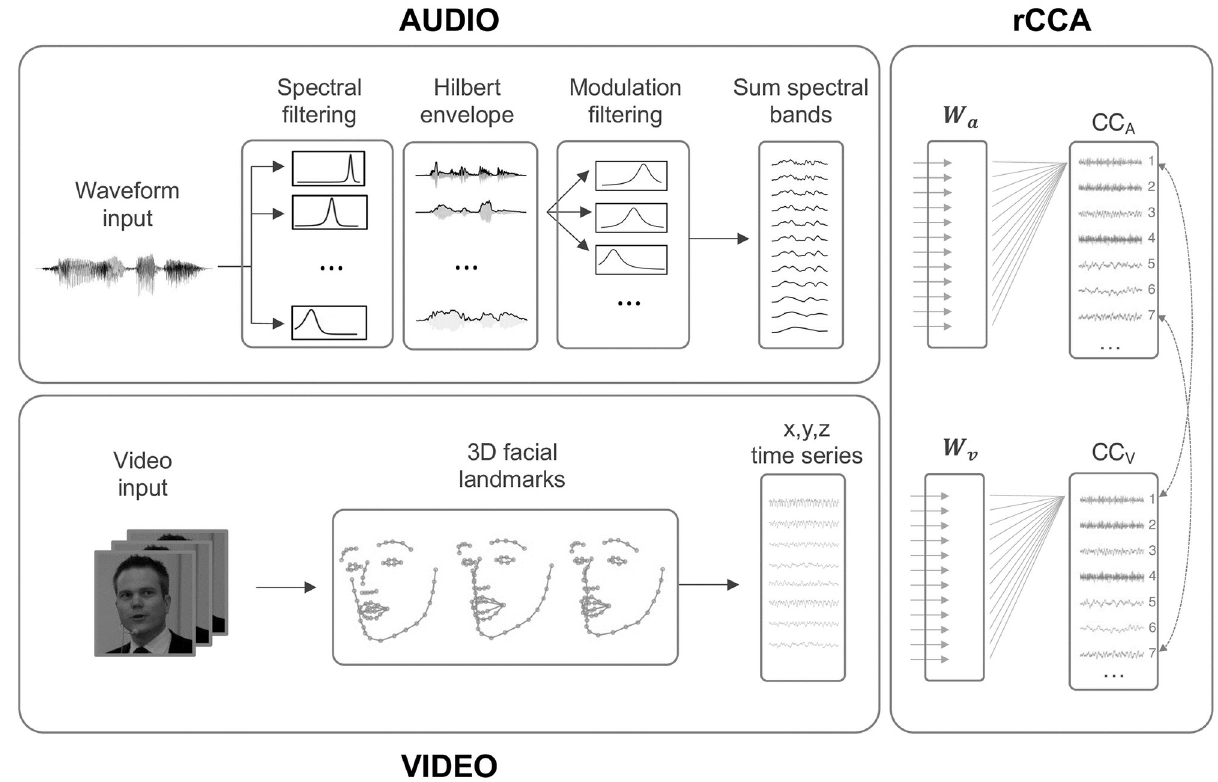
Fig 1. Analysis procedure. Regularized CCA (rCCA) combines speech envelope filter outputs and 3D landmarks of the speaker’s face. Resulting pairs of canonical components (CCs) are linear combinations of envelope filter outputs for audio (CC A ) and facial landmarks for video (CC V ). Image